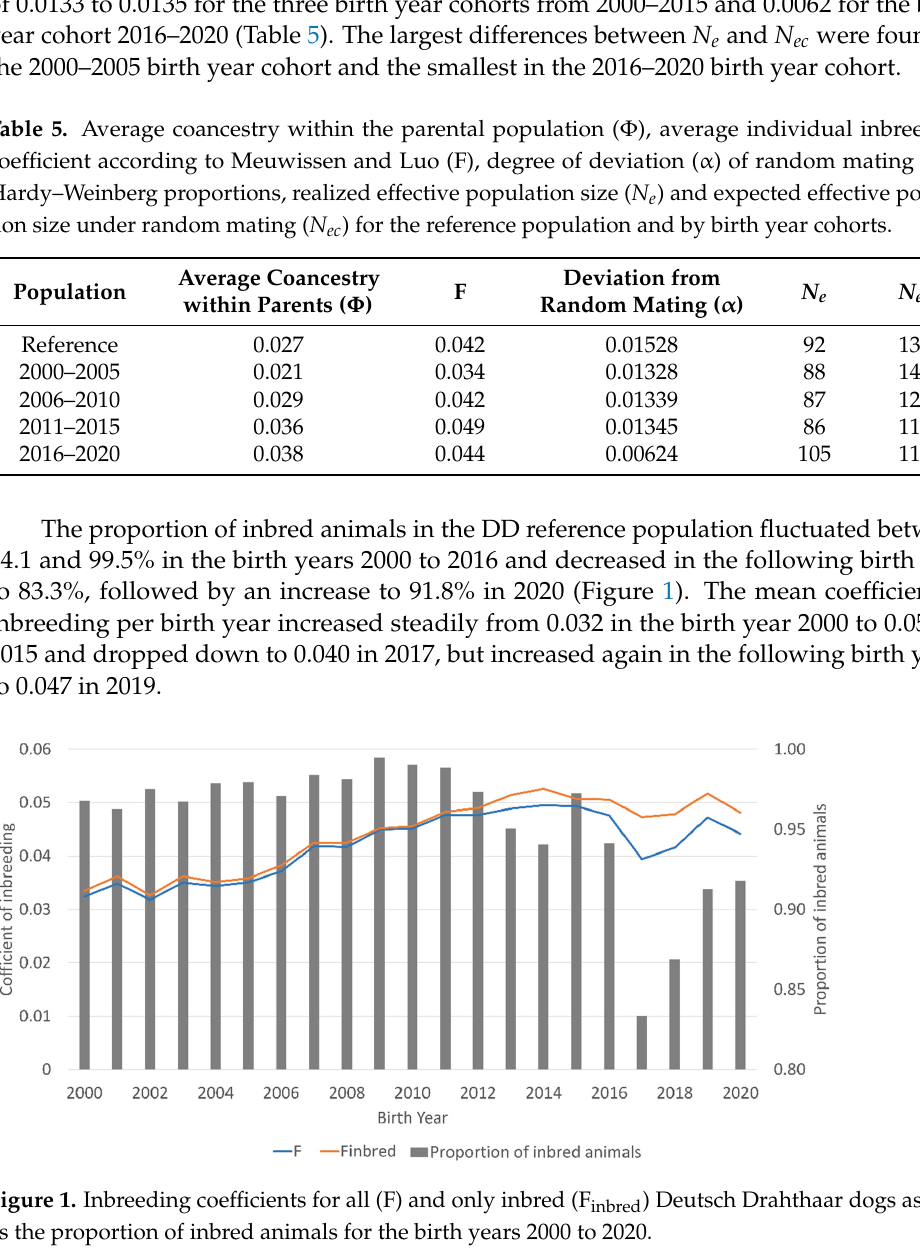
Figure 2. Ancestral inbreeding according to Ballou (F a_Bal ), ancestral (F a_Kal ) and new (F New ) inbreed- ing according to Kalinowski et al. and the ancestral history coefficient according to Baumung et al. (AHC) of Deutsch Drahthaar dogs for the birth years 2000 to 2020. The mean individual rate of inbreeding per generation was highest in the birth years 2000 and 2001, and between 2002 and 2016, Δ F i varied between 0.0054 and 0.0059 (Figure 3, Table S2). In 2017, Δ F i decreased to 0.0044 and increased to 0.0050 in 2019. N e was in- versely related to the individual rate of inbreeding per generation, with the lowest esti- mate of 79.3 in 2001 and the highest estimate of 114.2 in 2017.